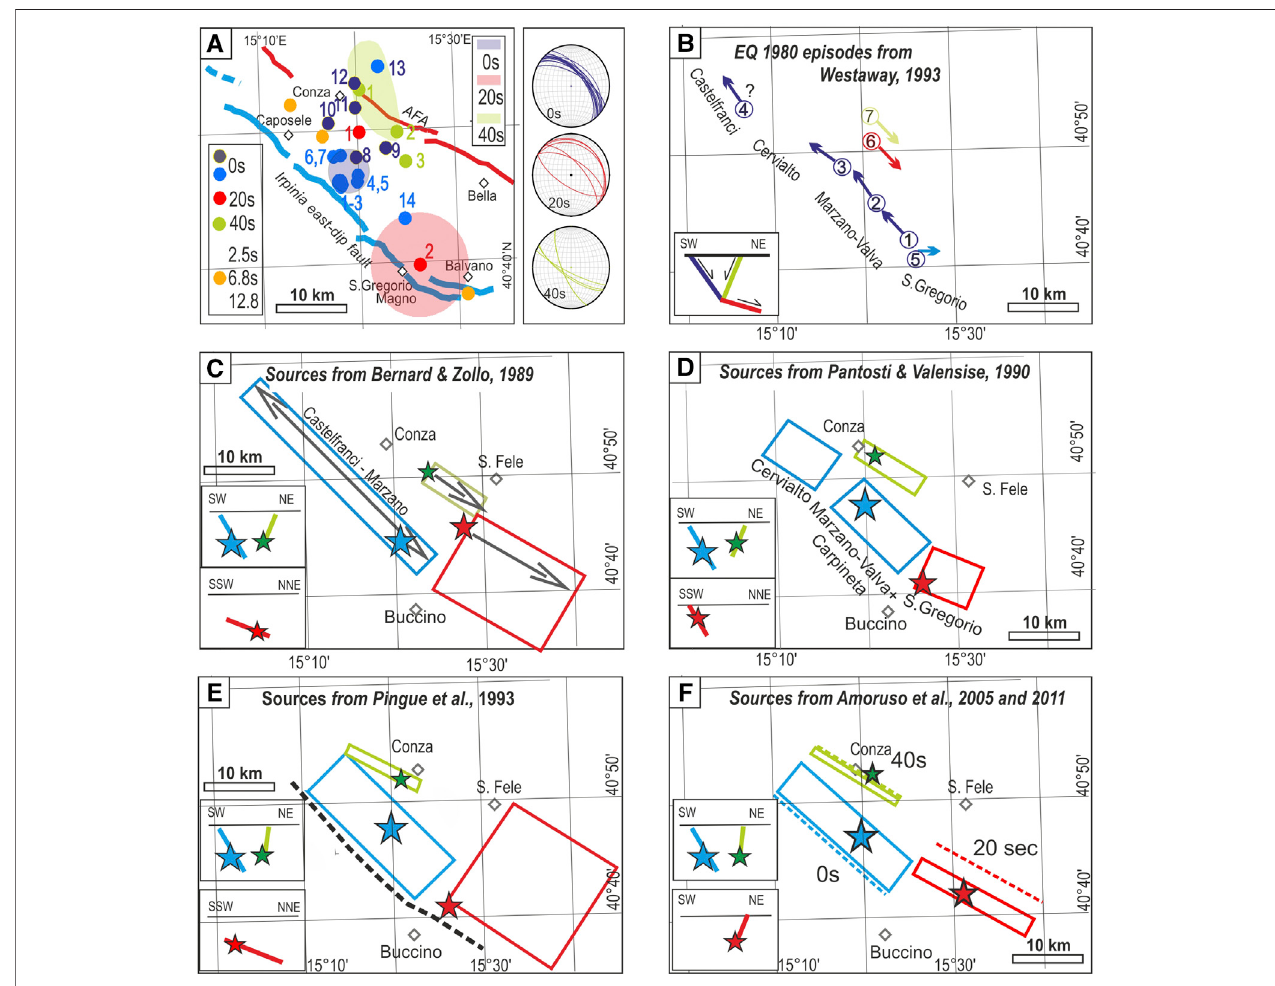
FIGURE2| Epicentrallocationsandsourcemodelsofthe1980Campania-Lucaniaearthquakefromtheliterature. (A) Summaryofepicentrallocationproposedby different investigators for the sub-event 1 (blue circles), sub-event 2 (red circles), sub-event 3 (green circles). The respective table with references is given in the supplementary material( Supplementary TableS3 ).Theorange circles areotherseismicepisodesoccurred at2.5, 6.8, and 12 sfrom thesub-event 1asinWestaway and Jackson (1987). The colored areas represent the seismic location uncertainty as in Bernard and Zollo, 1989. Summary of preferential fault plane solutions proposedinliterature forsub-events1 – 3( SupplementaryTable S4 ). (B – F) Thegeometryofthemainseismogenicsourcesofthethreeeventsrepresenting acomplex rupture mechanism occurred within 1 min of the onset of the main event (0, 20, 40 s) proposed by different investigators (Westaway and Jackson 1987; Bernard and Zollo 1989; Pantosti and Valensise 1990; Pingue and De Natale, 1993; Westaway, 1993; Troise et al., 1998; Dalla Via et al., 2003; Amoruso et al., 2005; Amoruso et al., 2011) Blue boxes refer to the fi rst event (0 s), red boxes to the second (20 s) and the green boxes to the third one (40 s). The inset inside each panel is the schematic cross section of the proposed